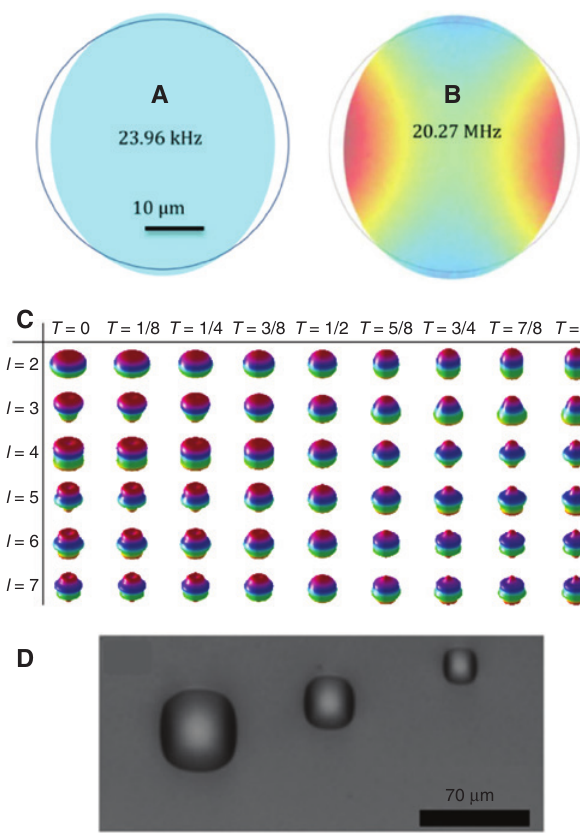
Figure 6: Capillary oscillations of liquid droplets. Comparison between (A) a theoretical capillary oscillation mode of a liquid (silicone oil) sphere in air and (B) its correspondent acoustic mode. The outer circle represents the contour of the sphere at rest and the colour represents pressure. In panel (A), the theoretical shape corresponds to the fundamental capillary oscillation mode (the mode number l = 2; l = 0 and l = 1 are zero-frequency